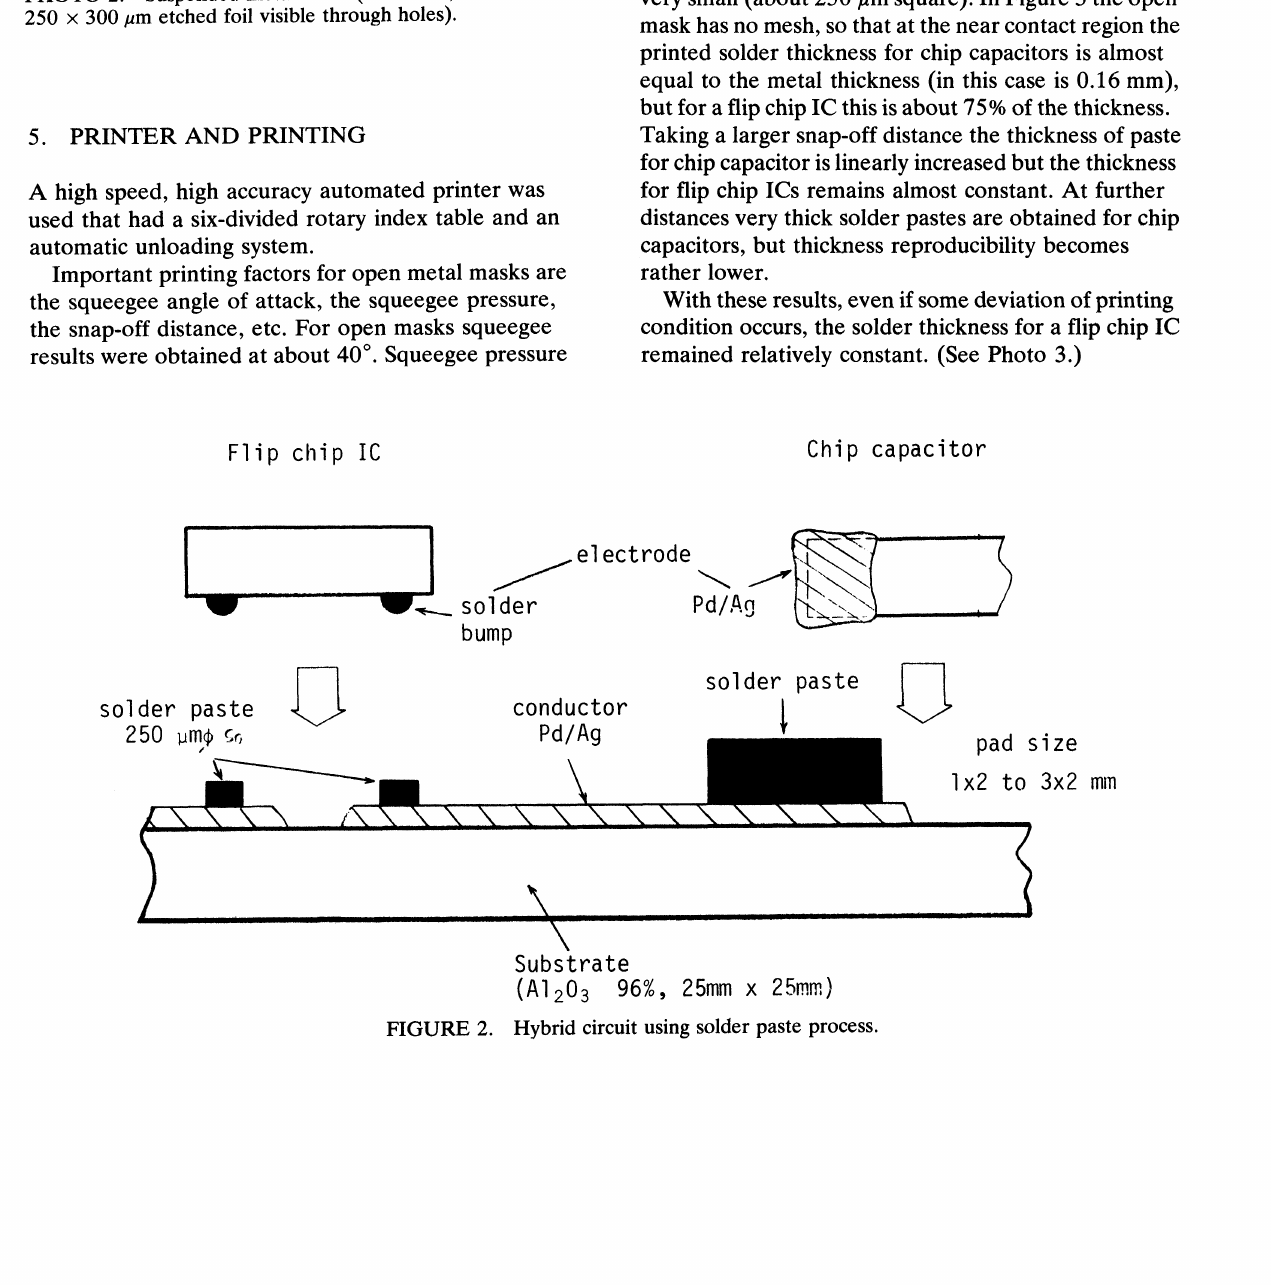
PHOTO 2. Suspended metal mask (120 mesh, 250 300/m etched foil visible through holes).